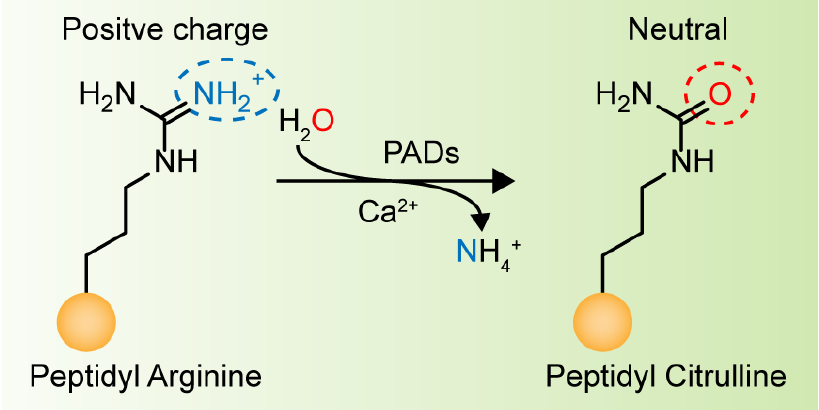
Figure 2. PAD-mediated citrullination: PADs catalyze the conversion of arginine to citrulline in protein with the participation of calcium ions.